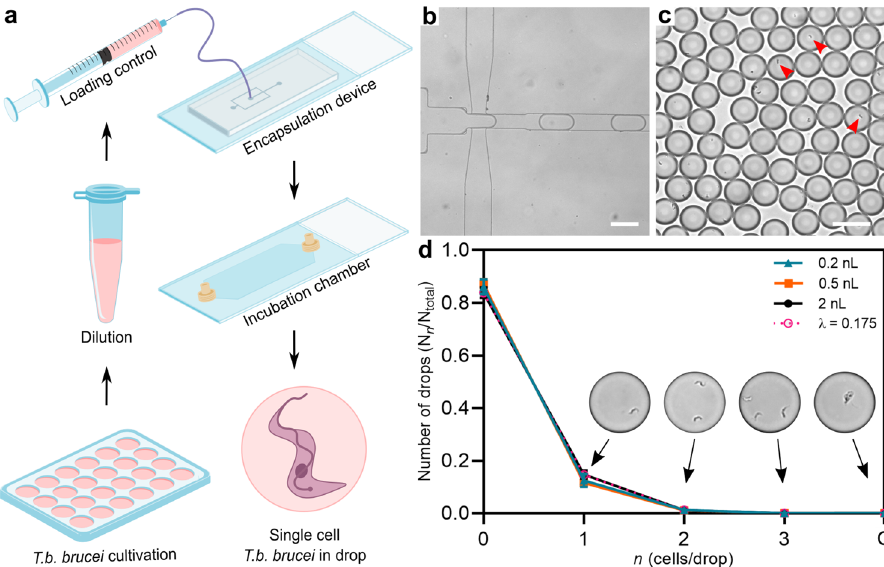
Figure 1. Single cell encapsulation of T.b. brucei . ( a ) Overview of experimental procedure. Starting from a classical cell culture, T.b. brucei cells are diluted to match the respective drop sizes used. After, the cell suspensions are loaded into syringes enabling connection to microfluidic devices. From encapsulation, the drops are loaded into an incubation chamber where visualization of encapsulated T.b. brucei takes place. ( b ) Microscopic image of drop-making process in personalized encapsulation device visualized through × 10 microscopic objective (Fig. S2a). ( c ) Fixed droplets containing encapsulated cells displayed in an incubation chamber visualized through × 10 microscopic objective. Red arrows highlight examples of encapsulated cells. ( d ) Poisson distribution of three different sizes of drops together with the predicted statistic values with a cell distribution of 0.175 cells per drop. All data are presented as mean values ±SD made as biological replicates (n = 3). Inserted images show examples of drops containing one, two, or three cells and an uncountable quantity defined as ‘clumps’ (C) using a × 20 microscopic objective. All scale bars are set to 100 µ m. Images displayed in a are used directly or modified in Inkscape (https:// inksc ape. org) from SMART (Servier Medical Art), licensed under a Creative Common Attribution 3.0 Unported License (https:// smart. servi er.